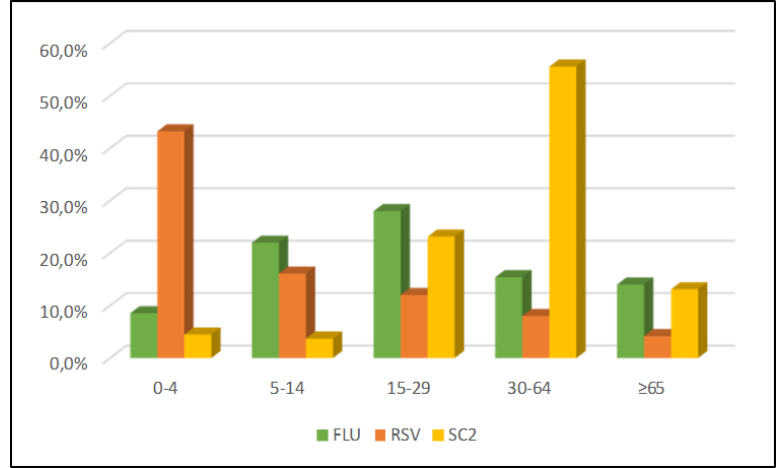
Figure 4. Age distribution of patients who tested positive for influenza (FLU), respiratory syncytial viruses (RSV), or SARS-CoV-2 detected from the Influenza Surveillance Network, January 2020 to May 2022, Madagascar.